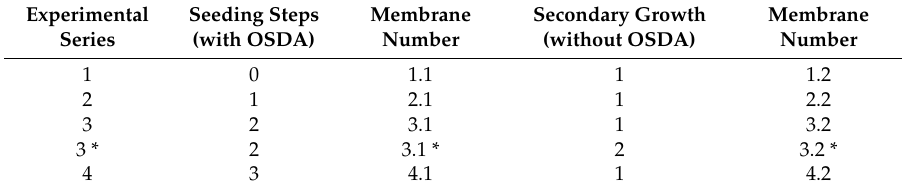
Table 1. Overview of the prepared membranes with increasing numbers of seeding steps with OSDA followed by one secondary growth step without OSDA. For the marked (*) sample, two consecutive secondary growth steps were performed.